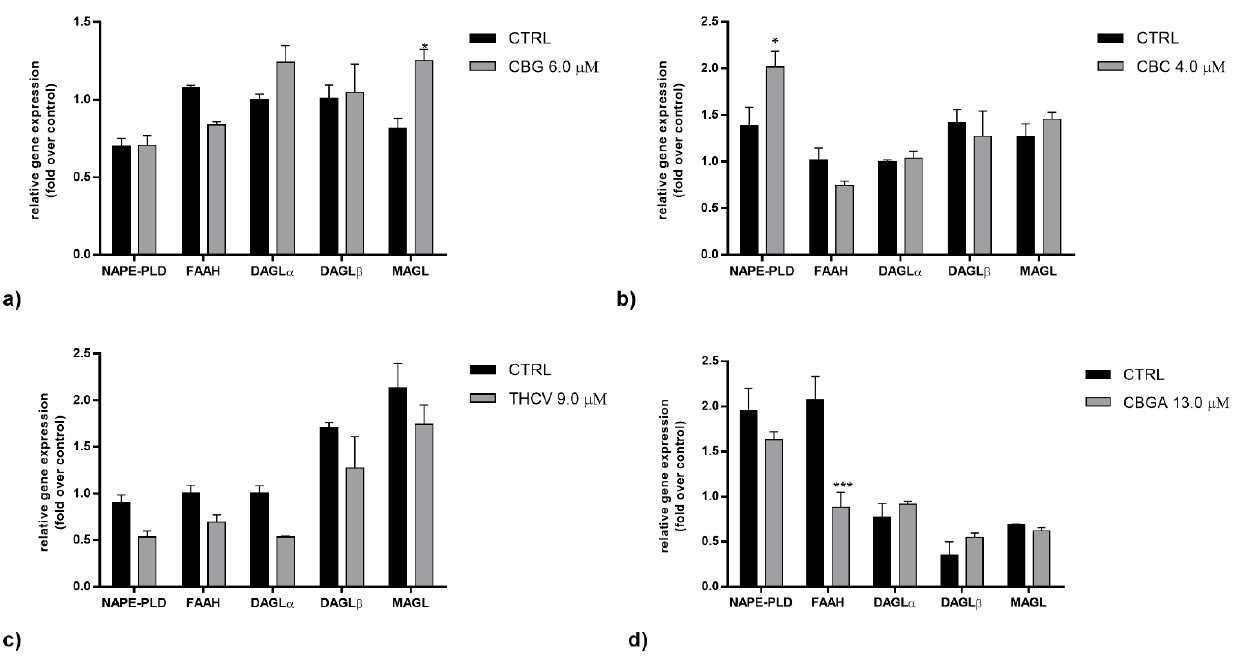
Figure 3. Gene expression of AEA and 2-AG metabolic enzymes (NAPE-PLD, FAAH, DAGL α / β and MAGL) following 24 h of treatment with half-IC 50 amounts of: ( a ) CBG, ( b ) CBC, ( c ) THCV and ( d ) CBGA. The values were expressed as 2 ( −ΔΔCt) and were normalized to β -actin and GAPDH as housekeeping genes. The data are the means ± SEM of three independent experiments ( n = 3). Statistical analysis was performed using a two-way ANOVA test, followed by the Bonferroni post hoc test (* p < 0.05 and *** p < 0.001 vs. control).